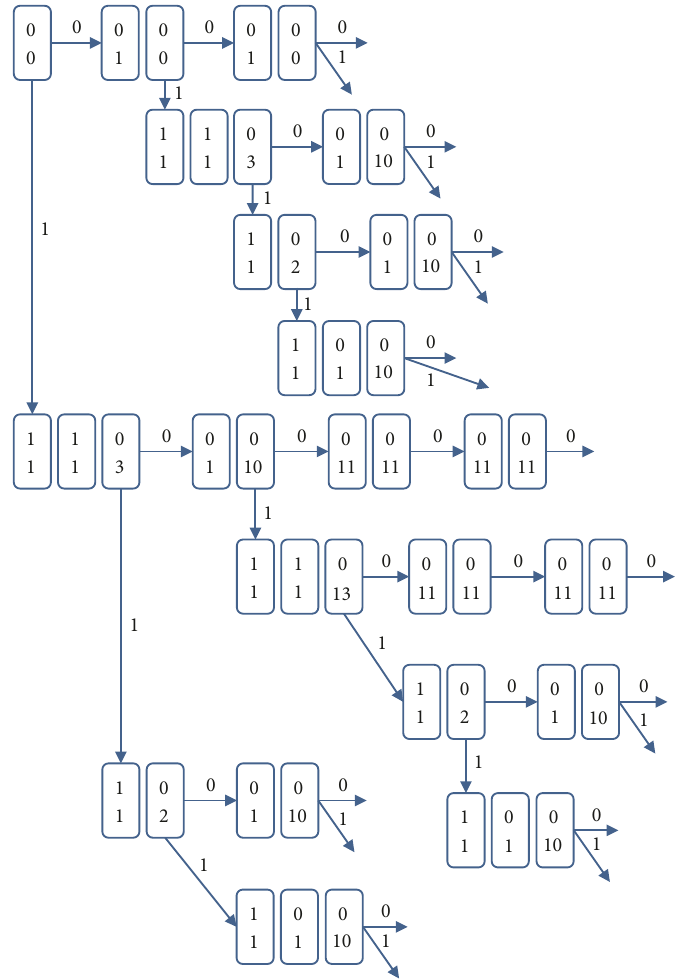
Figure 2: Iteration of part-time